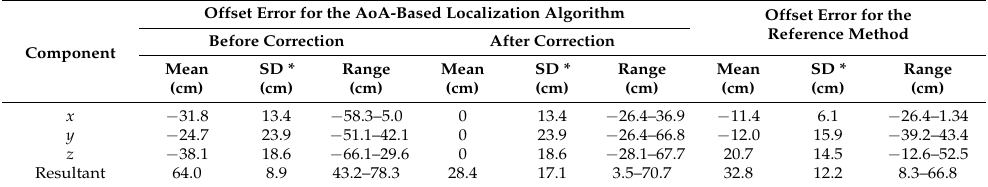
Table 4. Characteristics of the experimental results of the offset error for the 36 spatial location samples for the AoA-based localization algorithm before and after correction, and the reference algorithm for LS’s AD